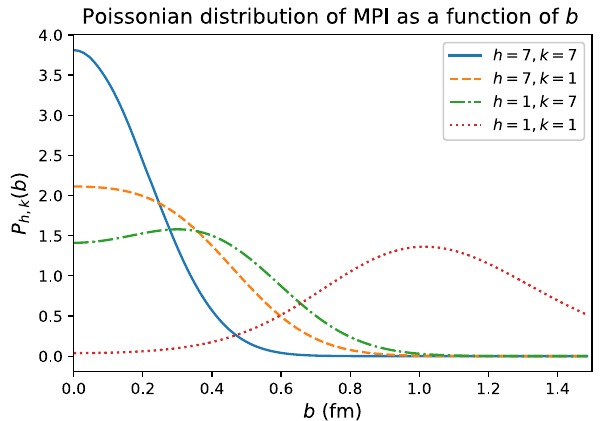
Fig. 1 Joint Poissonian distribution P h , k ( b ) , as a function of impact parameter b , for a number of h hard scatters and k soft scatters. We have picked one large (7) and one small (1) value, and show the vari- ous combinations. The more collisions that occur, the more likely the collision is to be central. Keeping the number of interactions fixed but having more soft interactions makes the distribution have a broader tail. We have used the following fixed values for the normalized dis- = 83 mb, σ inc = 127 mb, μ 2 = 0 . 71 GeV 2 , and tributions: σ inc hard soft hard μ 2 = 0 . 52 GeV 2 . These distributions are normalized independently soft to unit